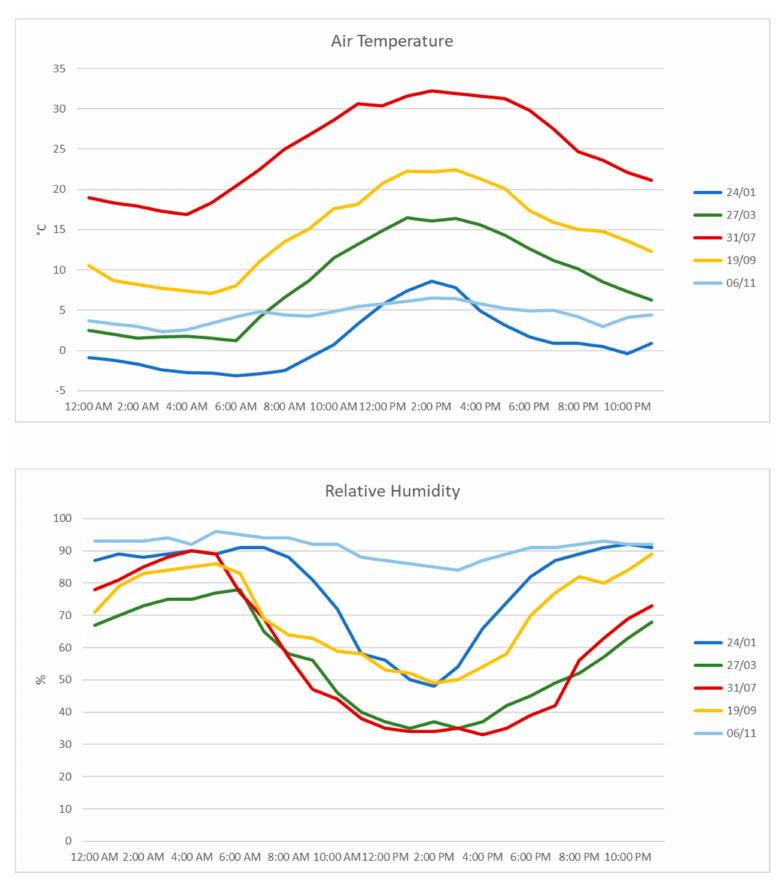
Figure 3. Typical air temperature and relative humidity of selected